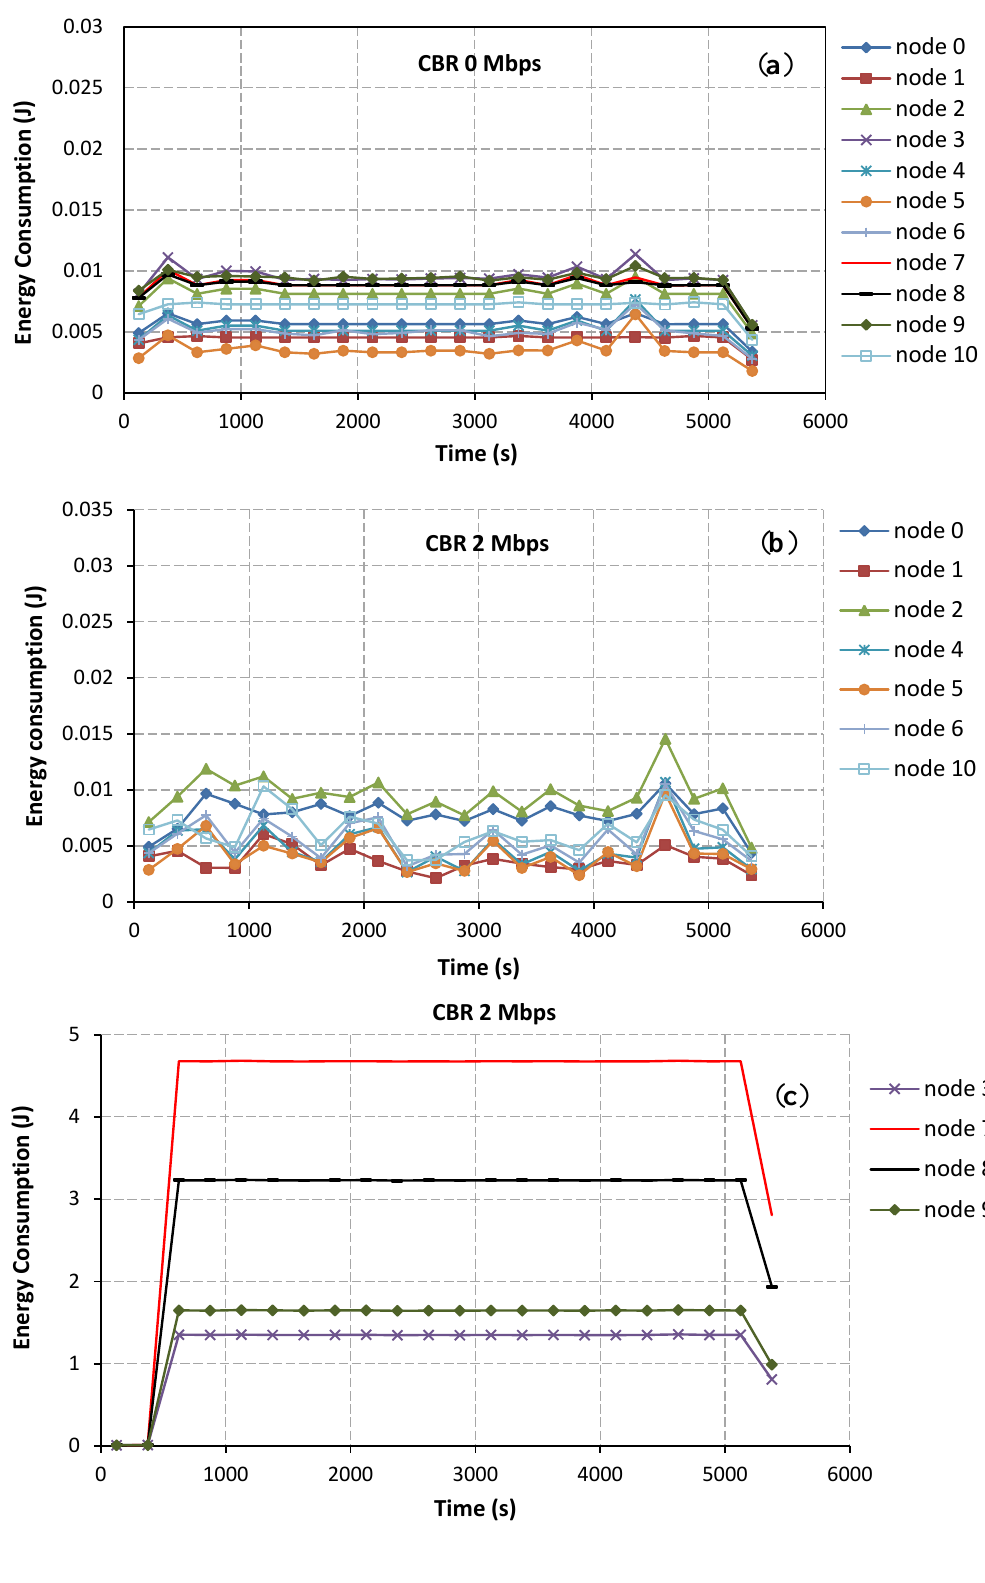
Figure 8. Energy consumption of each node at each window interval vs . CBR rate. ( a ) At the CBR rate of 0 Mbps. ( b,c ) At the CBR rate of 2 Mbps. ( d,c ) At the CBR rate of 3.25